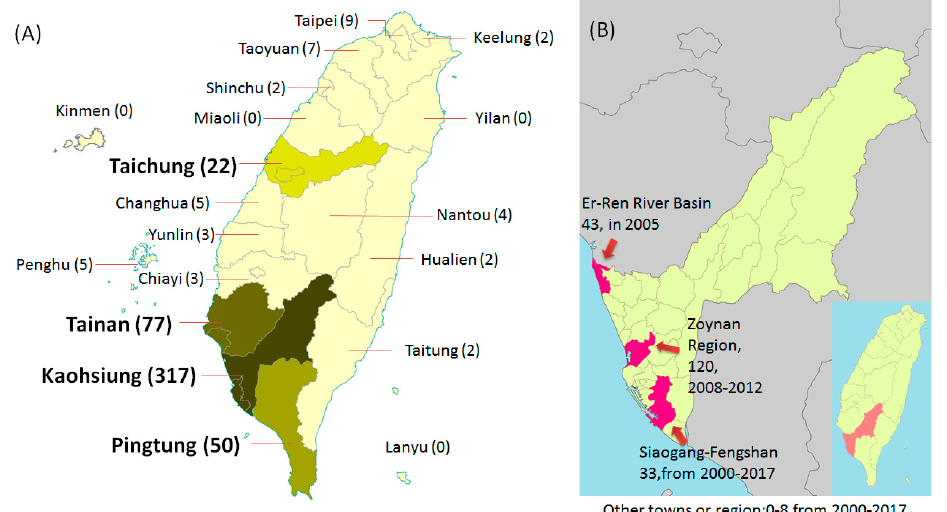
Figure 1. Geographical distribution of melioidosis in Taiwan. ( A ) In the entire island with the case number shown in brackets. ( B ) In Kaohsiung district. Two hot spots (Er-Ren River Basin and Zoynan Region) and Siagogan-Fengshan (location, case number, and year in which it occurred) are shown as red color.